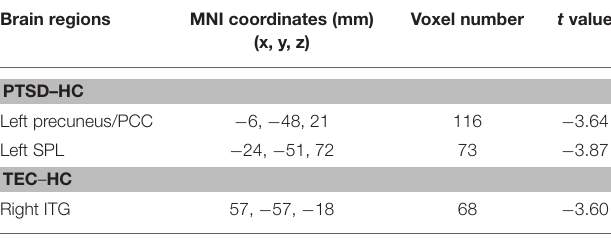
TABLE 3 | Comparison of the effective connectivity from the right amygdala. Brain regions